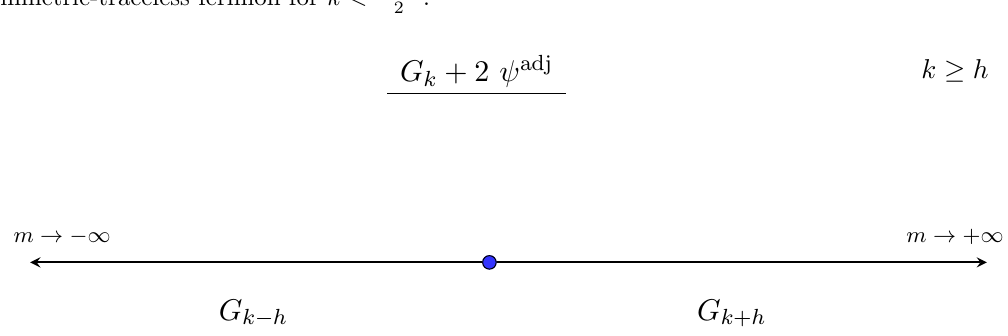
Figure 5 . The proposal of [4] for the Phase diagram of SO( N ) k gauge theory with a single real symmetric-traceless fermion for k < N +2